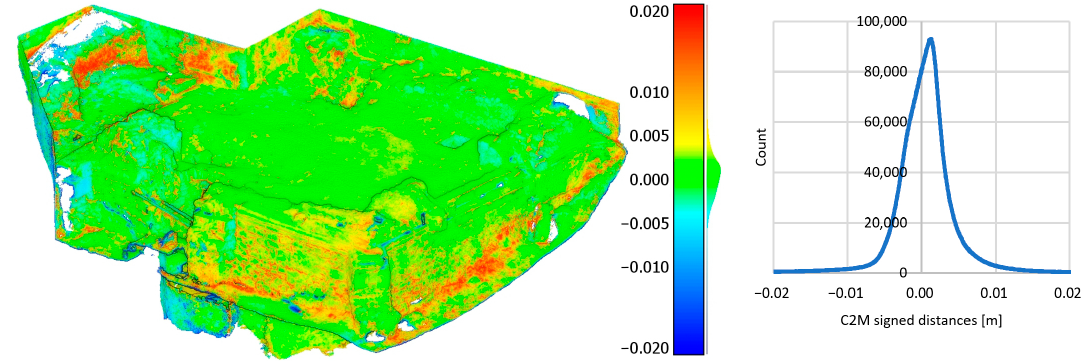
Figure 10. Deviations in comparison of TLS and photogrammetry with all images active (TLS vs. A) ( left ), and histogram of the deviations ( right ).